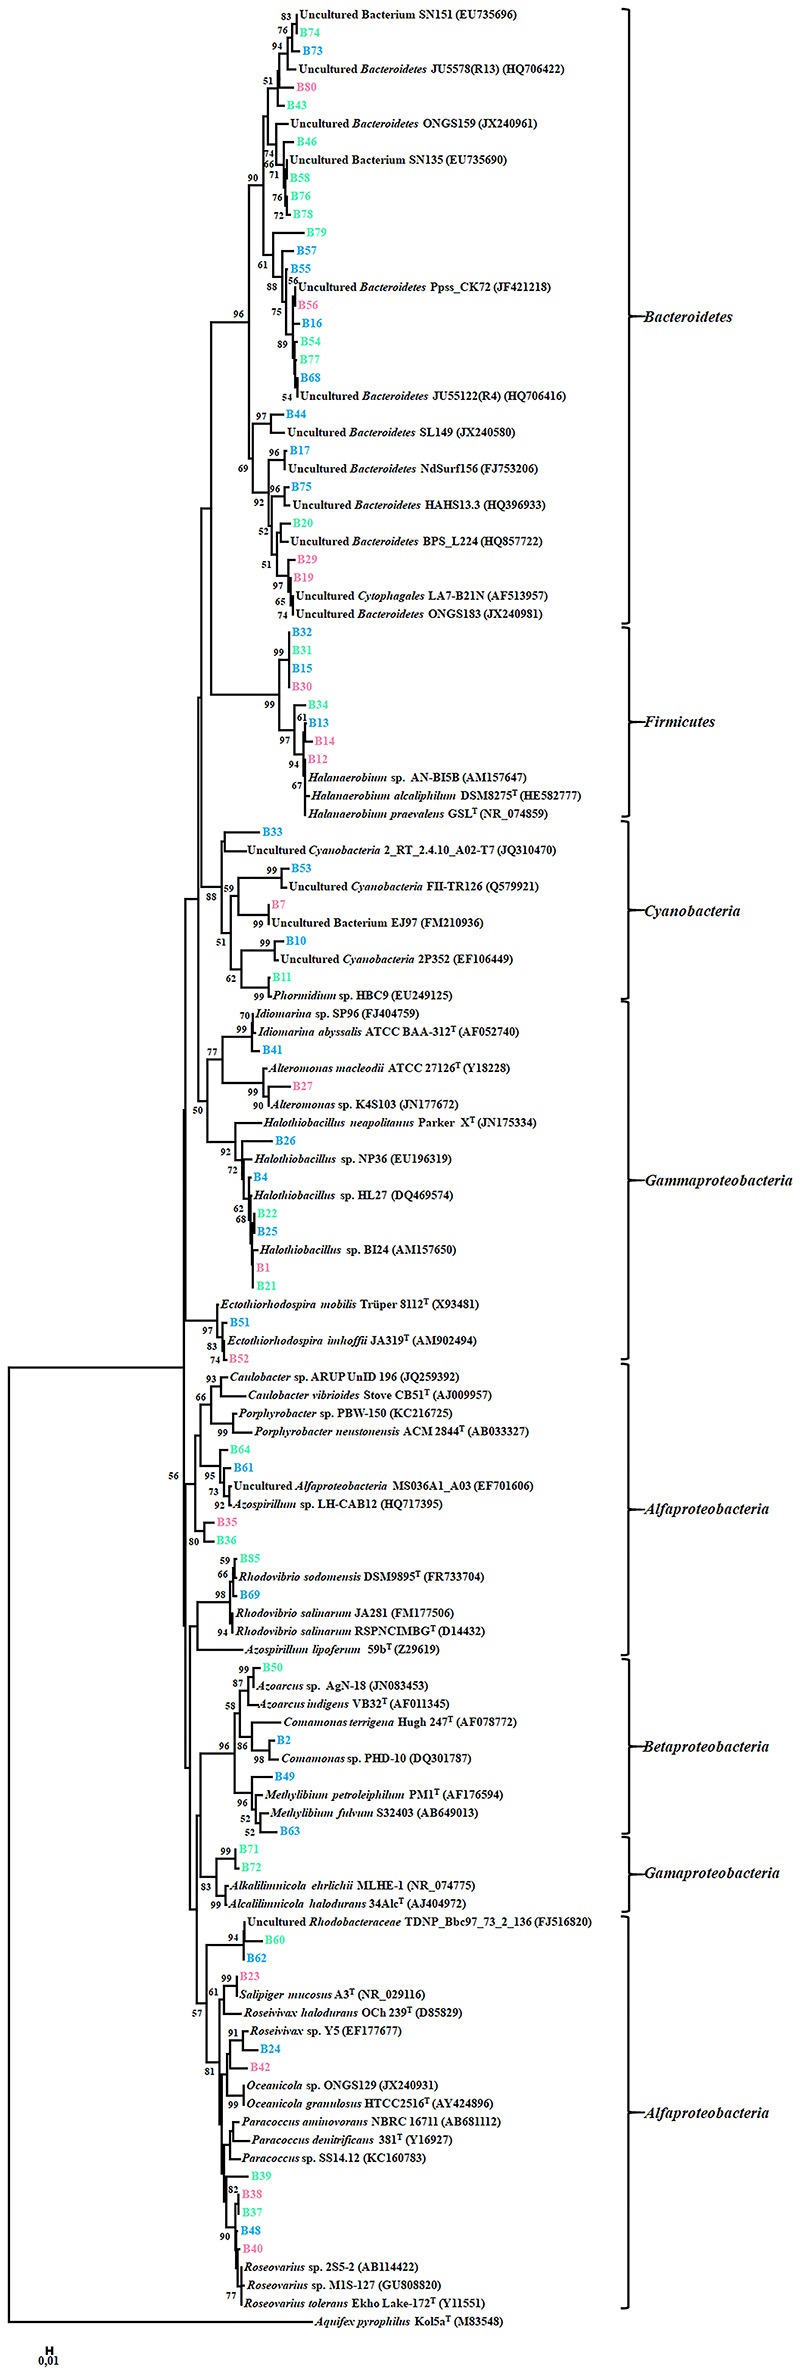
Neighbor-joining phylogenetic tree showing the relationships between the 67 bacterial sequences from the DGGE bands and the most similar sequences retrieved from the GenBank/EMBL/DDBJ database. The scale bar indicates 0.01% divergence. Bootstrap values over 50% are shown in nodes.